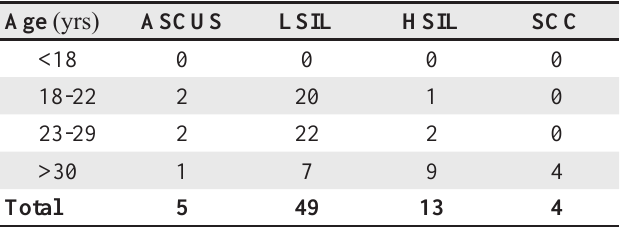
Table 2 : Epithelial cell abnormality in Pap smear in different age groups